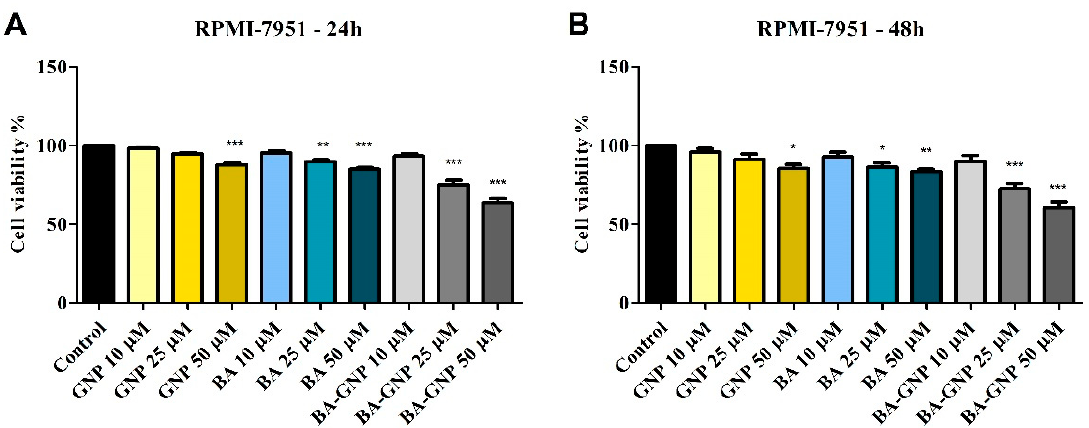
Figure 7. Cell viability of RPMI-7951 cells after 24 h (A) and 48 h (B) treatment with GNP (diluted to match the same gold content as for BA loaded NPs at 10, 25 and 50 μΜ ), BA and BA-GNP (10, 25 and 50 μΜ ). The results are expressed as cell viability percentage (%) normalized to control (100%). The data represent the mean values ± SD of three independent experiments performed in triplicate. The statistical differences vs. control was determined using one-way ANOVA analysis followed by Tukey’s multiple comparisons post-test (* p < 0.05, ** p < 0.005 and *** p < 0.0001).